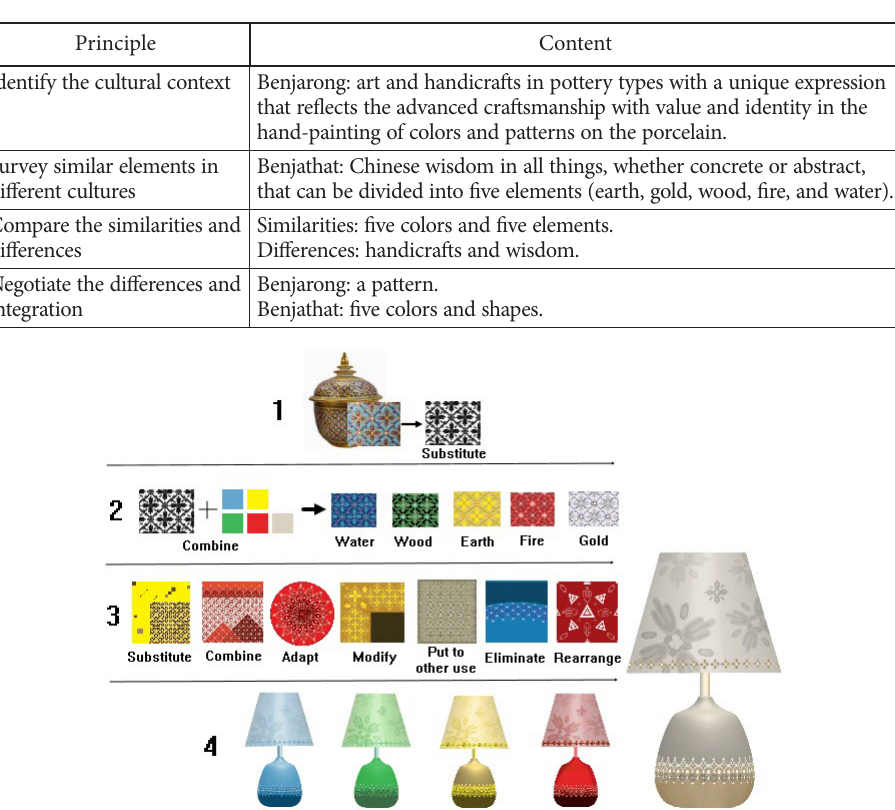
Table 1. Analysis of core ideas in the bicultural context of Benjarong and Benjathat (source: created by author)